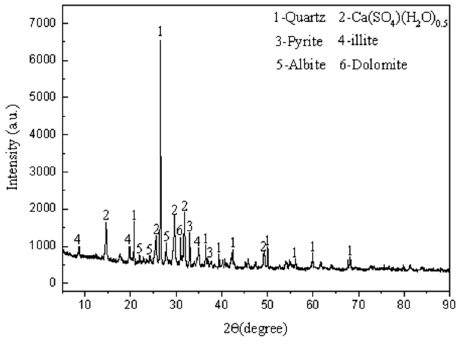
Table 1. Main technical specifications of X-ray photoelectron spectrometer.